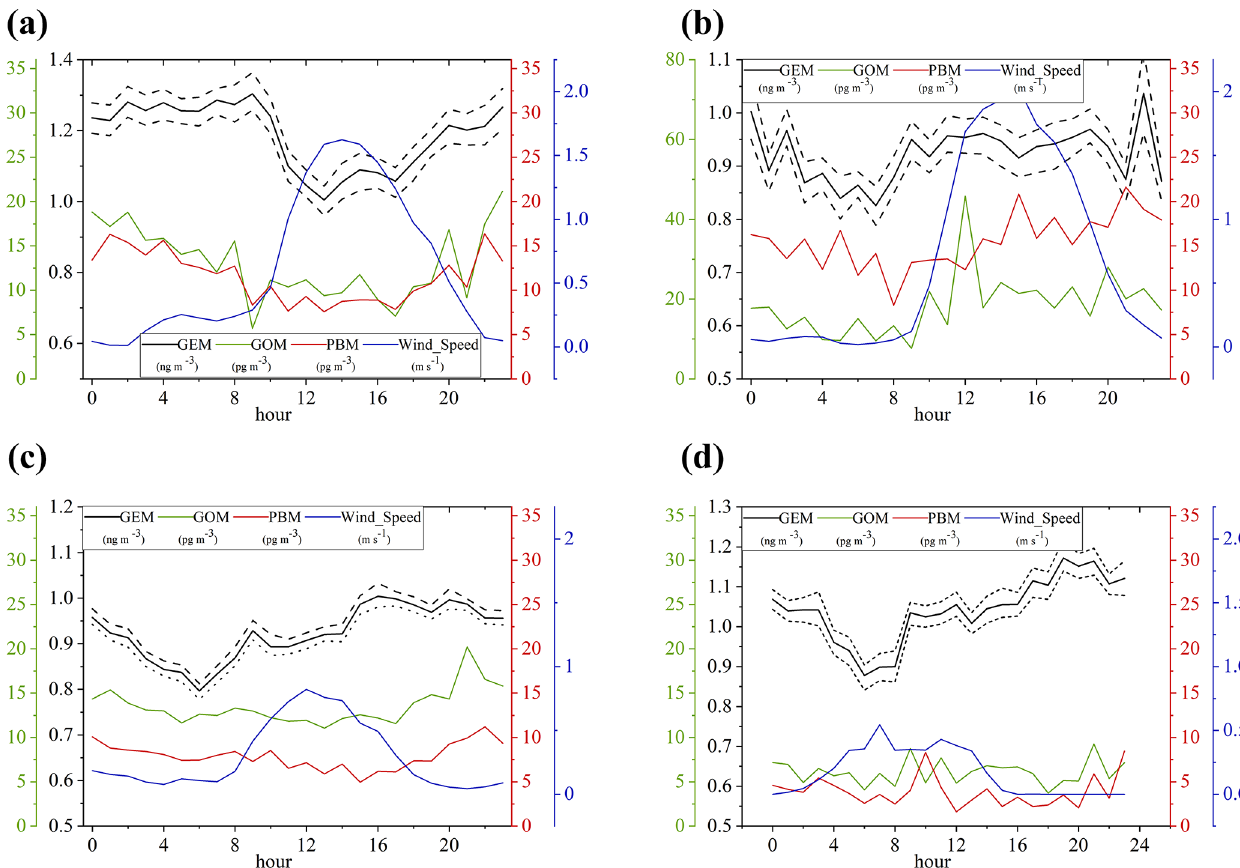
Figure 4. Diurnal variation of Hg species, concentrations of some other pollutants and meteorological information from PISM to ISM1– ISM3 periods. The short horizontal line represents the concentration error range for each time